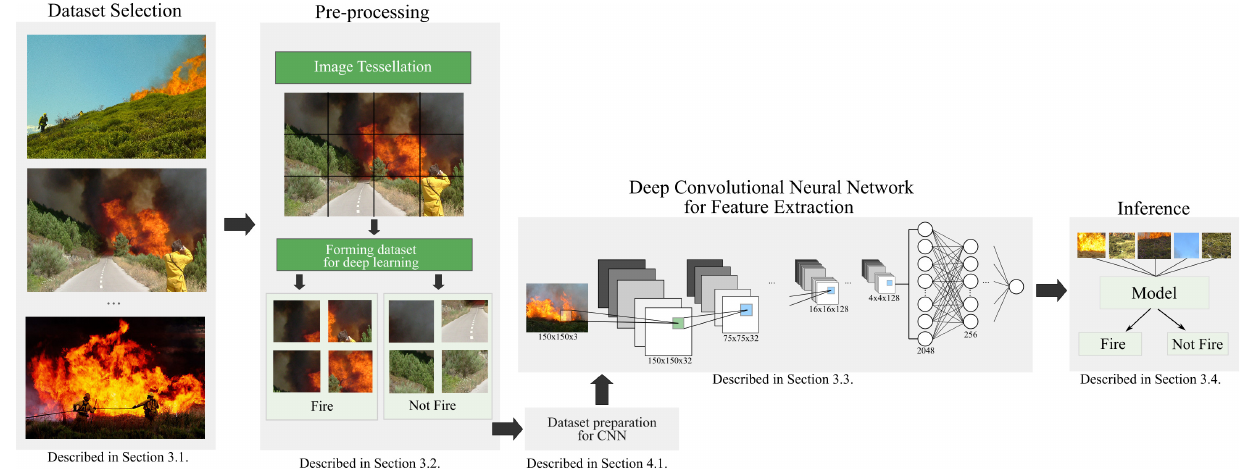
Figure 3. Overview of phases in the proposed method. We propose a new pre-processing approach to create a new dataset that consists of two classes (fire and not-fire). Then, we prepare the dataset for training, validation, and testing for the newly proposed deep convolutional neural network. The dataset is fed into the proposed lightweight CNN model to carry out binary